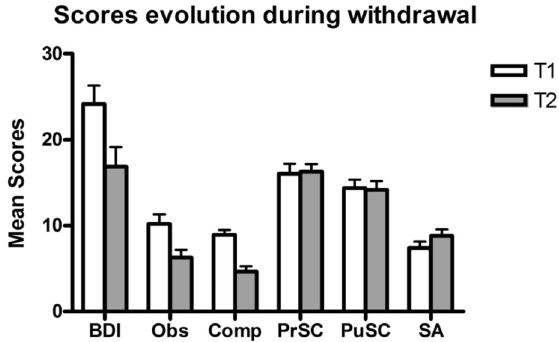
Figure 1. Evolution of scores of depression, craving and self consciousness during alcohol withdrawal. Depression scores were measured with the BDI (Beck et al., 1996; Bourque and Beaudette, 1982), obsessional (Obs) and compulsional (Comp) subscores of craving were measured by the OCDS (Anton et al., 1995, 1996; Ansseau et al., 2000), and self-consciousness were measured by the RSCS with subscores of Private (PrSC) and Public (PuSC) Self-Consciousness and Social Anxiety (SA) (Pelletier and Vallerand, 1990; Scheier and Carver, 1985) at both the onset (Time 1) and at the end (Time 2) of protracted withdrawal.